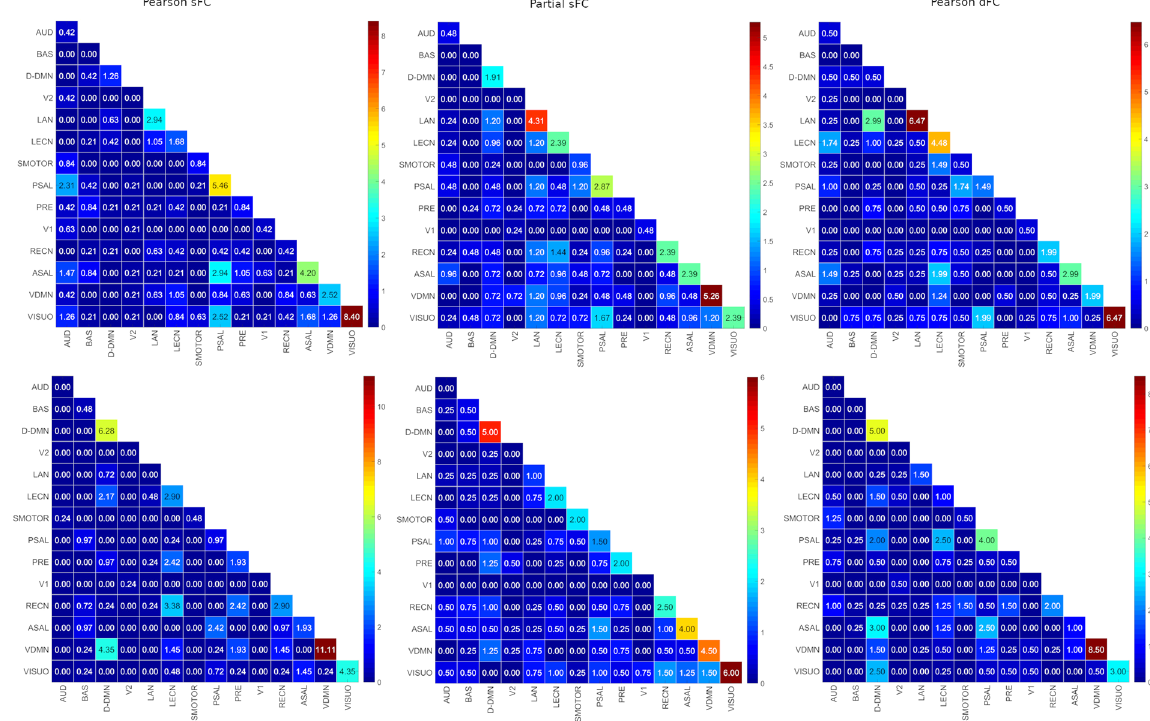
Figure 4. Differential power of edges using Pearson sFC, Partial sFC and Pearson dFC methods for males (TOP) and females (BOTTOM). The color bar to the right of each figure displays the mapping of edge differential power values to the color map. AUD-Auditory, BAS-Basal Ganglia, DDMN-Dorsal Default Mode Network, V2-Primary Visual, LAN-Language, LECN-Left Executive Control Network, SMOTOR- Sensorimotor, PSAL-Posterior Salience, PRE-Precuneus, V1-High Visual, RECN-Right Executive Control Network, ASAL-Anterior Salience, VDMN-Ventral Default Mode Network, VISUO-Visuospatial.